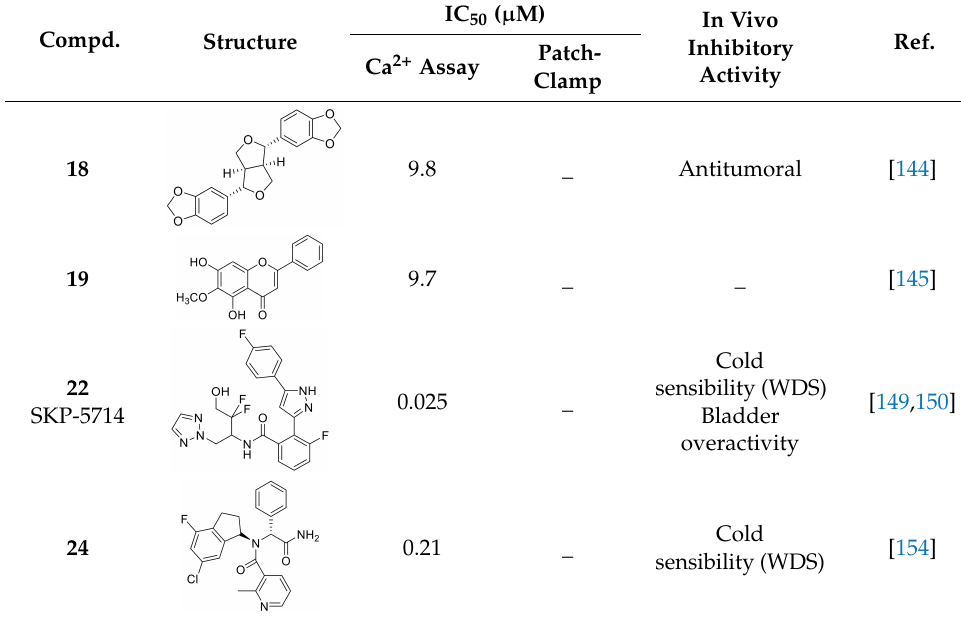
Table 2. Representative examples of newly described families of TRPM8 antagonists.